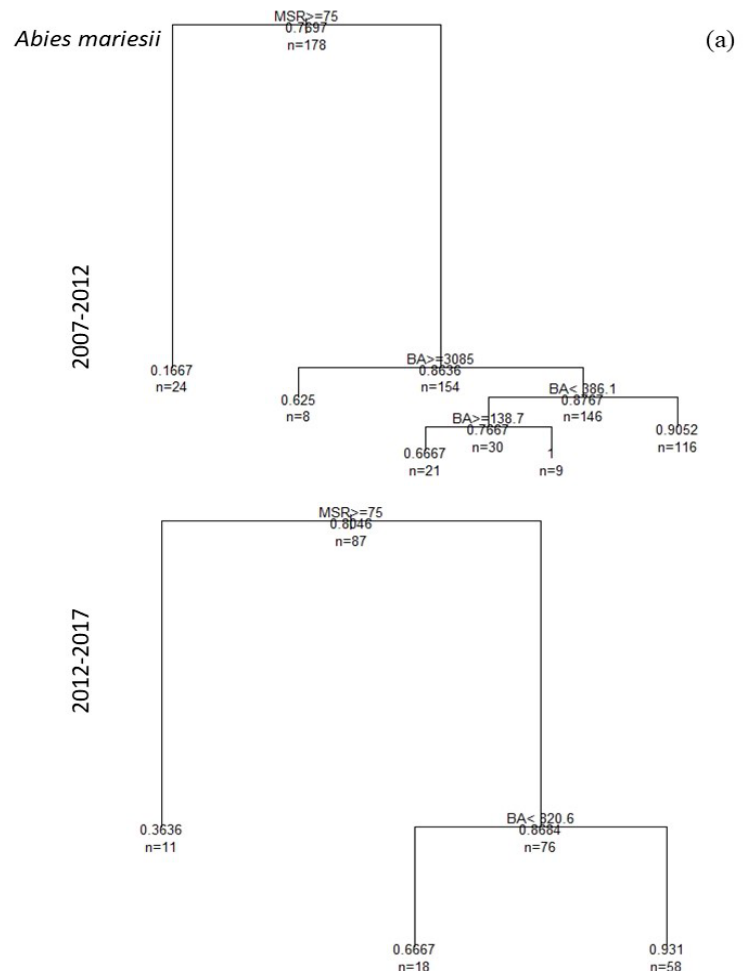
Figure 4. Results of tree regression models drawn to clarify the factors affecting survivorship of Figure 4. saplings of the three conifer species. At the first node, the first line gives the most influential factor affecting the survival and the threshold values. Threshold values of the explanatory variables recursively divide the data into homogeneous clusters at each node, according to whether they meet the criterion (death to the left and survive to the right). MSR—maximum bark stripping ratio; BA—basal area; D—diameter at breast height; Reg—regeneration mode. ( a ) Abies mariesii